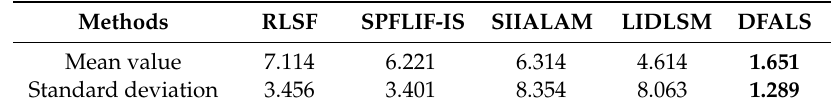
Table 1. The mean value and standard deviation of P d given by di ff erent methods on the test images.